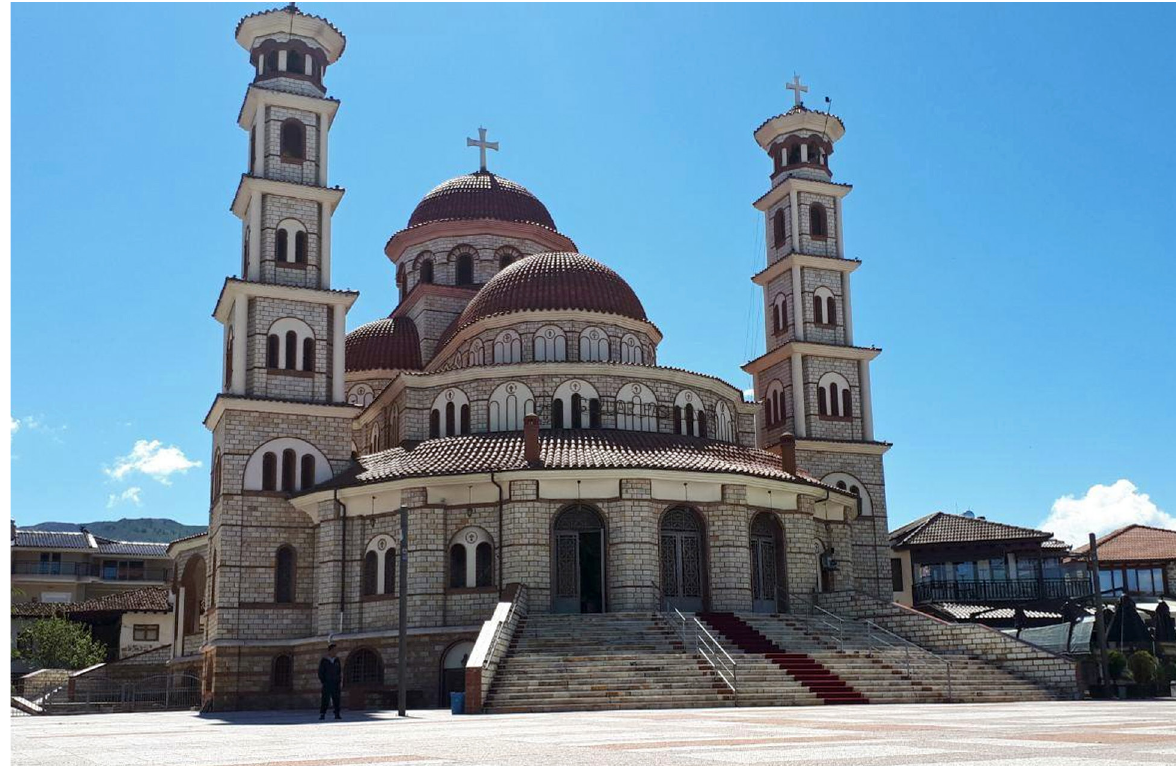
Fig. 2. The Ringjallja e Krishtit ( Resurrection of Christ ) Cathedral in the city of Korça.